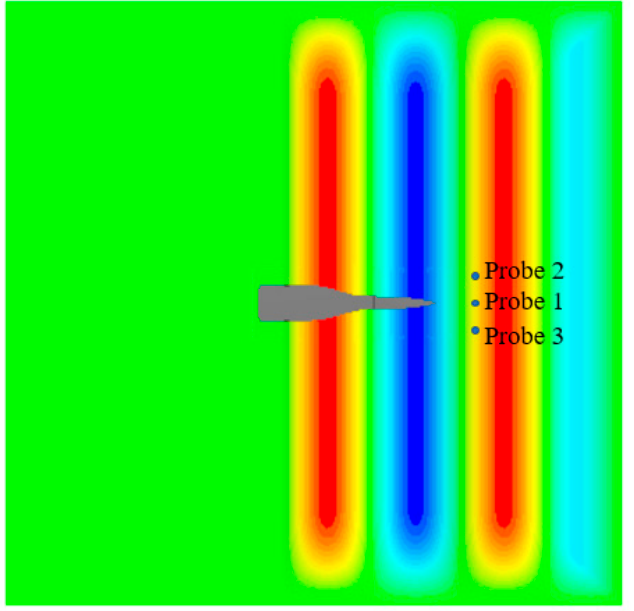
Figure 8. Simulated waves and wave probe